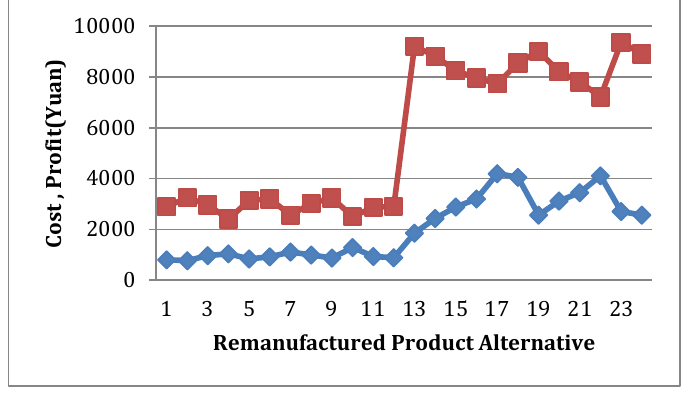
Blue: cost, Red: Profit Source : Jiang, Ding, Zhang, Cai & Liu